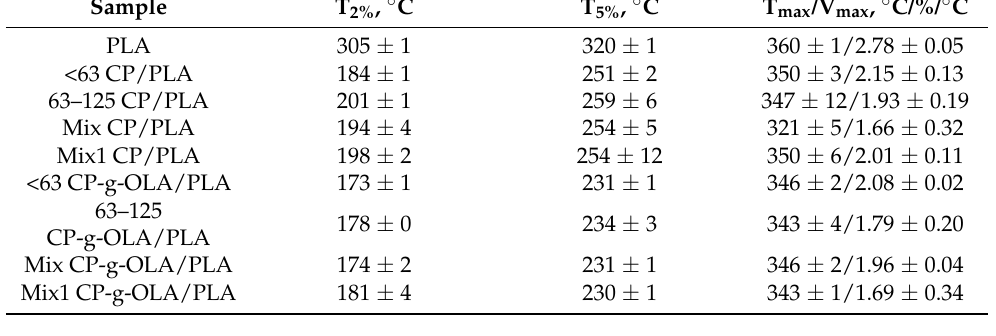
Table 9. TGA results of PLA and biocomposites.